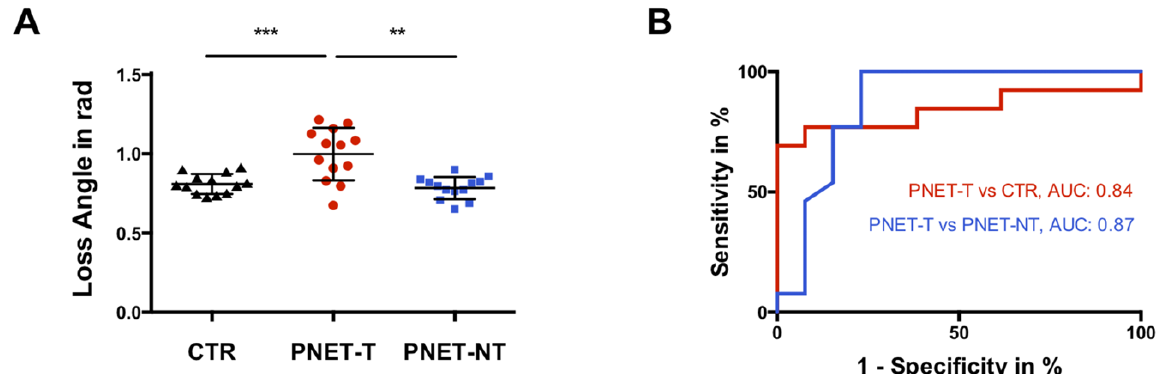
Figure 3. ( A ) Boxplot of loss angle of complex shear modulus of controls (CTR; black triangles; n = 13), tumorous pancreatic region in participants with pancreatic neuroendocrine tumor (PNET-T; red circles; n = 13) and nontumorous pancreas in participants with pancreatic neuroendocrine tumor (PNET-NT; black squares; n = 13). *** p < 0.001; ** p < 0.01. ( B ) Receiver operating characteristic curves for assessing diagnostic performance of loss angle of the complex shear modulus in differentiation of PNET-T from CTR and PNET-T from PNET-NT with calculated area under the receiver operating characteristic curve (AUC).